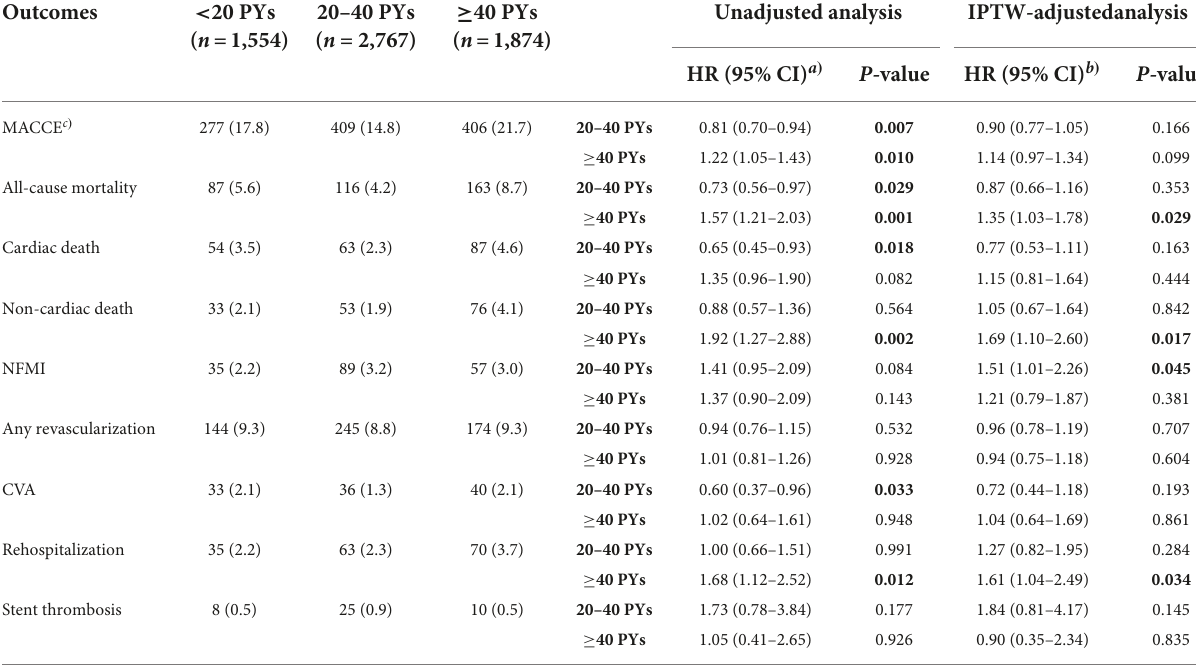
TABLE 4 Three-year clinical outcomes in patients before and after IPTW